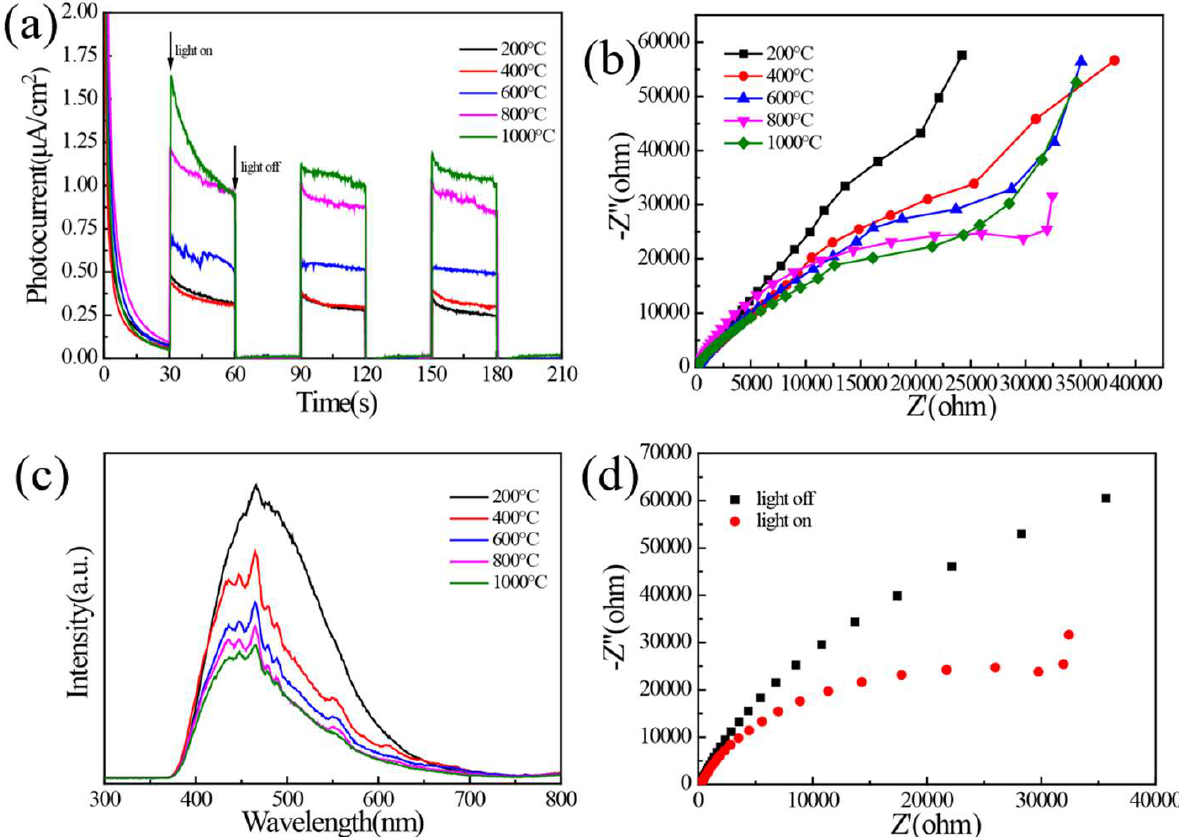
Figure 6. TPR ( a ), EIS ( b ), and PL ( c ) of the as-prepared HAP samples calcined at different temperatures, ( d ) the EIS diagram of HAP samples calcined at 800 °C for 2 h when the light was on and off.